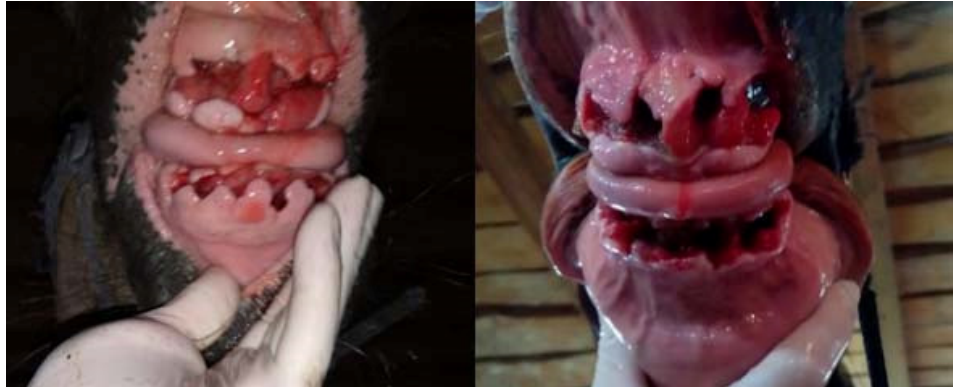
Figure 11. The condition of the tooth extraction sockets during the first change of alveolar dressings 4 days after the procedure (on the left—case 1, on the right—case 2).